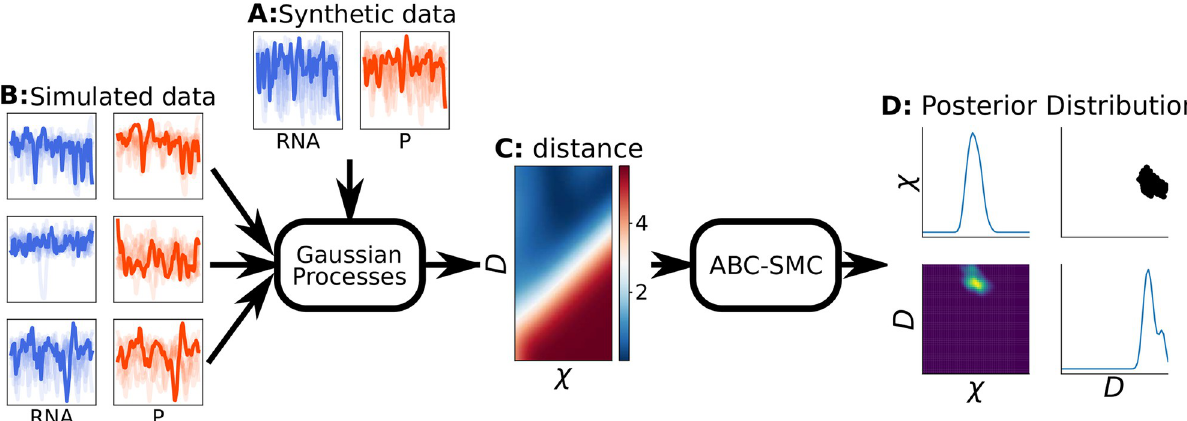
Fig 1. Parameter inference pipeline based on Gaussian processes. A map of distance metric values based on one synthetic data set (A) is trained using all other simulated data sets (B). This distance metric map (C) is then used in pyABC to infer the parameters of the synthetic data set using ABC-SMC (D), i.e in this way we avoid sampling additional data points during ABC inference points using expensive simulations.